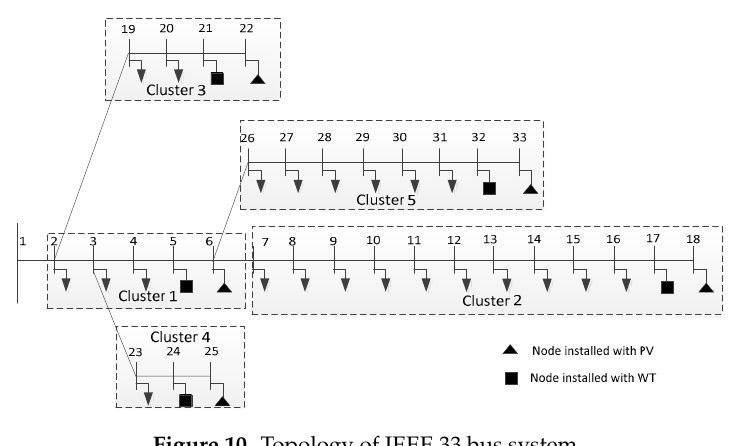
Figure 10. Topology of IEEE 33 bus system. Table 6. Planning capacities of WT / PV of Cases 5–8 for the IEEE 33 bus system.